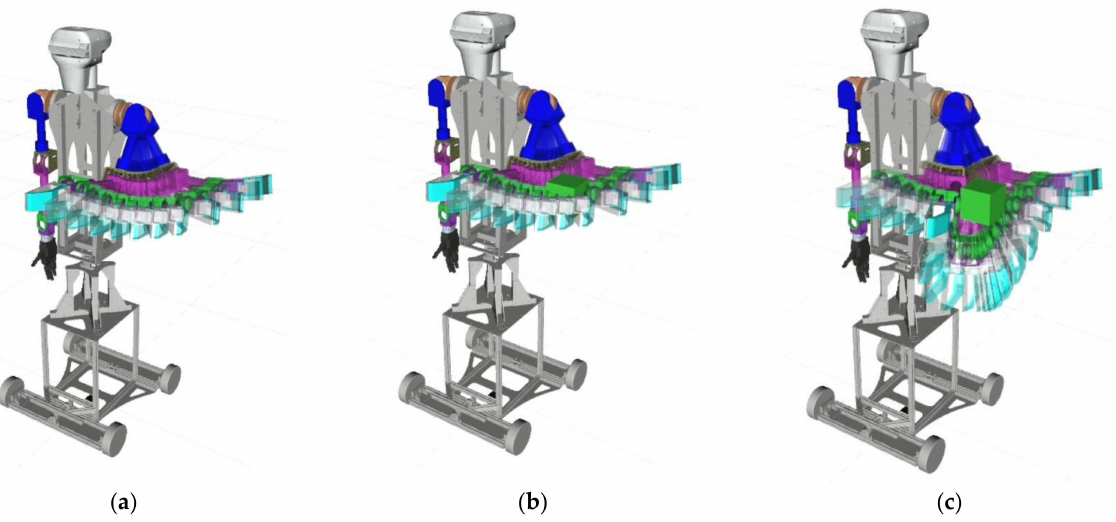
Figure 6. The DGLP provides local re-planning path during the robot simulation. ( a ) The global path of the manipulator. ( b ) The partial invalid path because of the environmental change. ( c ) The local path is planned by the DGLP and merged into the global path.